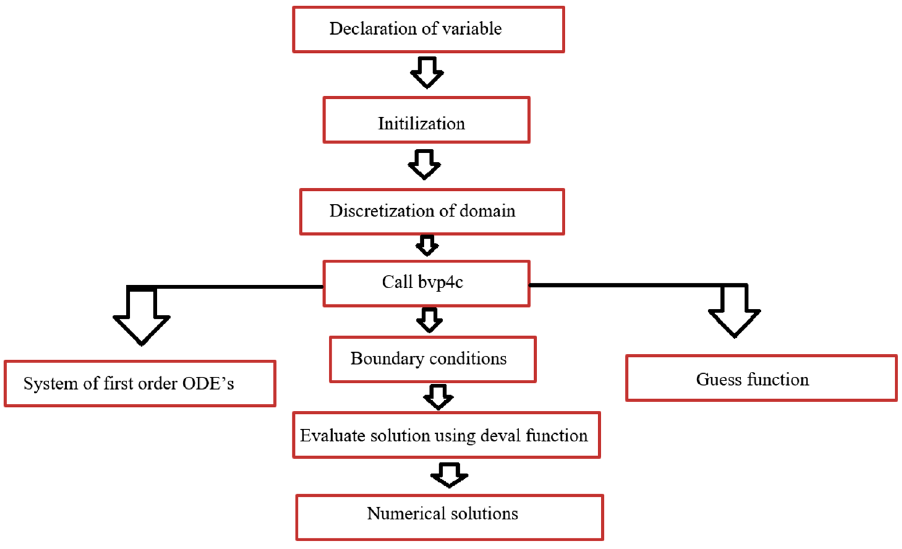
Figure 2. Flow plan of numerical